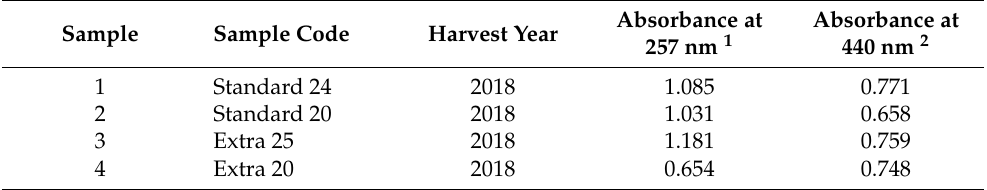
Figure 4. UV-Vis spectra of ( a ) picrocrocin solution obtained from SPE with 15% ACN/water ( v / v ), ( b ) crocins solution obtained from SPE with 50% ACN/water ( v / v ). Table 1. Absorbance values of picrocrocin at 257 nm and crocin solutions at 440 nm, obtained under the optimized SPE conditions from twenty saffron